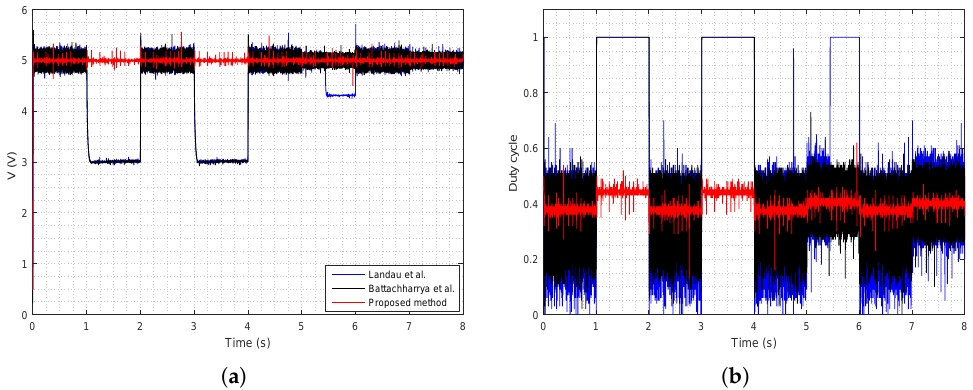
Figure 16. Experimental results of the output voltage when the system subject to a load variation. ( a ) Capacitor voltage; ( b ) Duty